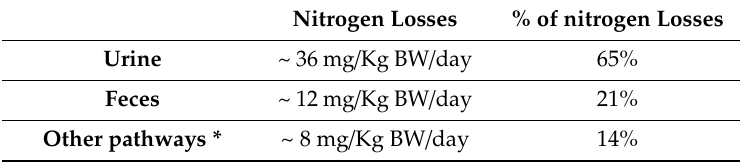
Table 3. Nitrogen losses by type of excretion and per kg of body weight in healthy adult